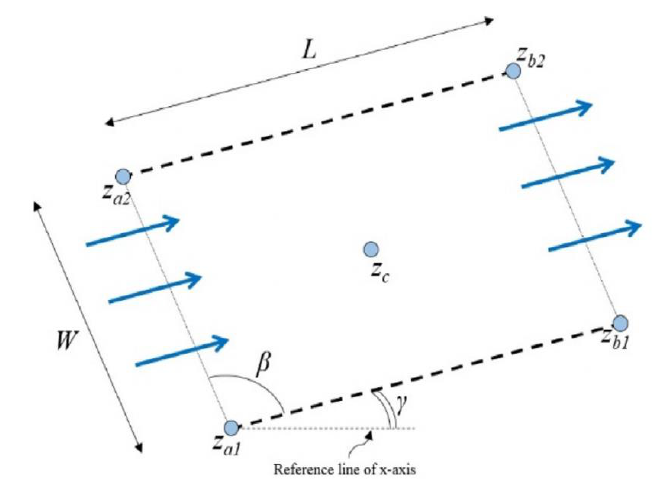
Figure 2. Natural fracture model. L and W are the length and width; z c is the center; z a 1 , z a 2 , z b 1 , and z b 2 are the corners; β is the wall angles, while γ is the rotation angle of the natural fracture. The blue arrows give the direction of the flow [22].